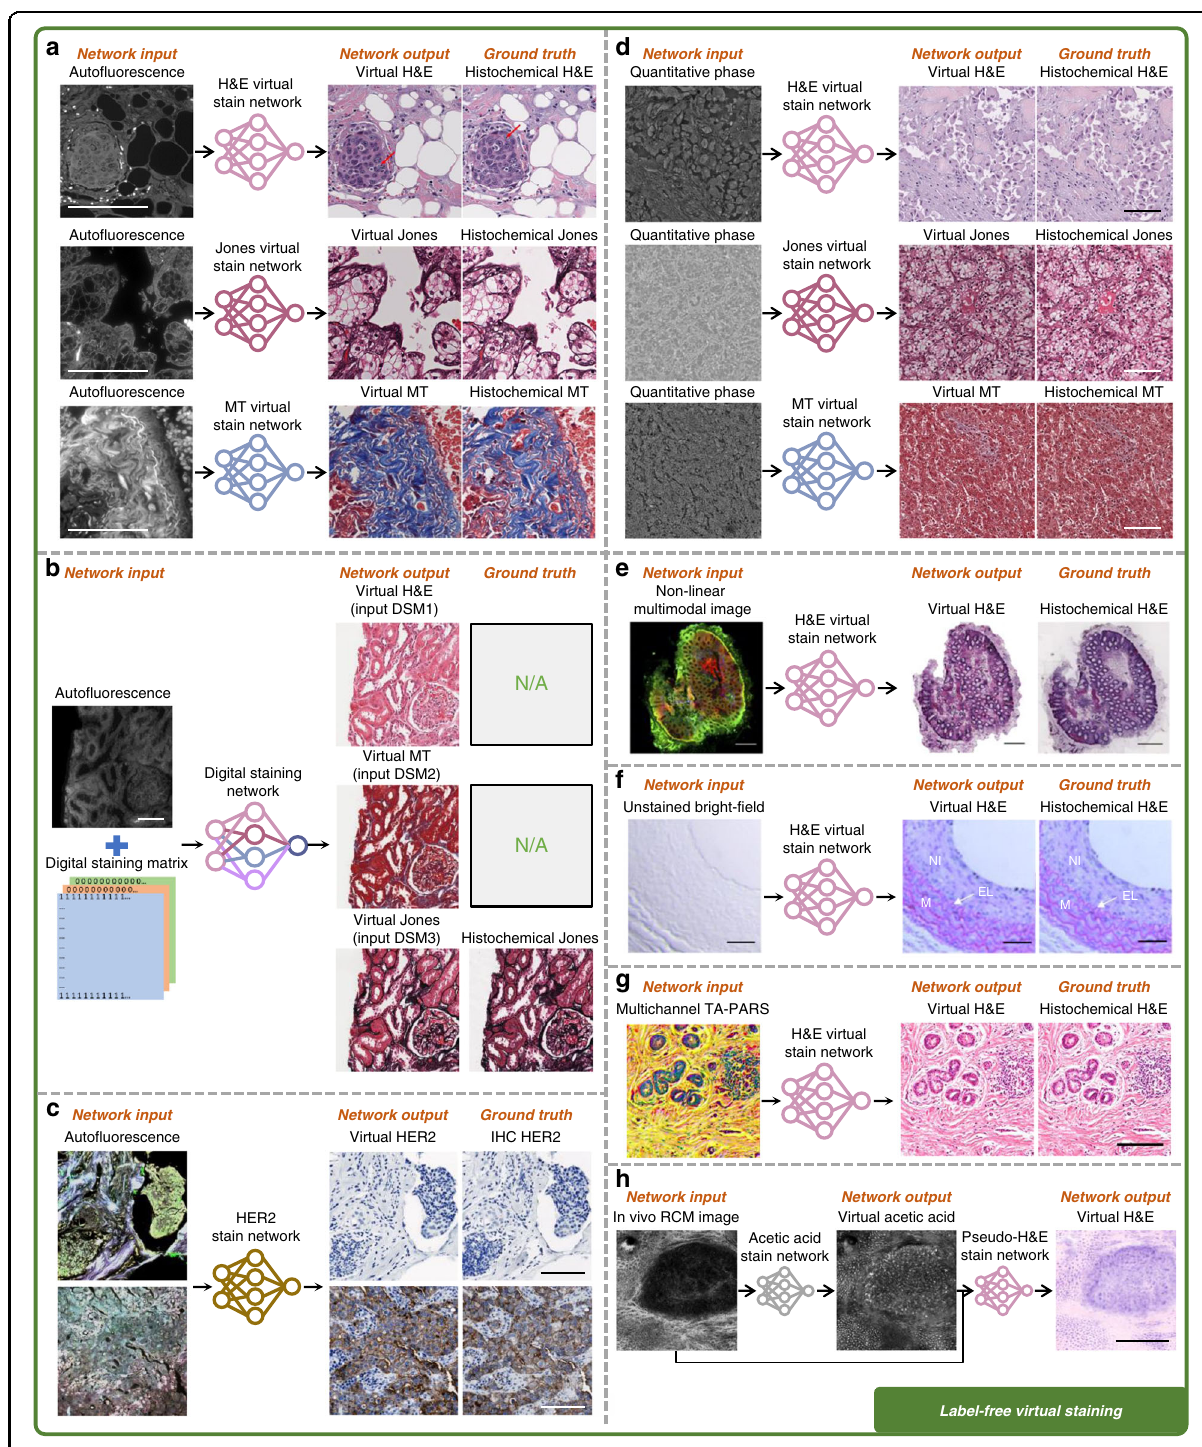
Fig. 4 Examples of label-free virtual staining using different input imaging modalities. a Virtual H&E, Jones silver, and MT staining using auto fl uorescence images 18 . b Multiplexed H&E, Jones silver, and MT staining using a single network with auto fl uorescence images and digital staining matrix as input 22 . c Virtual IHC HER2 staining using auto fl uorescence images 31 . d Virtual H&E, Jones silver, and MT staining using quantitative phase images (QPI) 20 . e Virtual H&E staining using nonlinear multi-modal images 35 . f Virtual H&E staining using bright- fi eld images 36 . g Virtual H&E staining using TA-PARS images 38 . h Virtual acetic acid and H&E staining using in vivo RCM images 38 . All the scale bars represent 100 μ